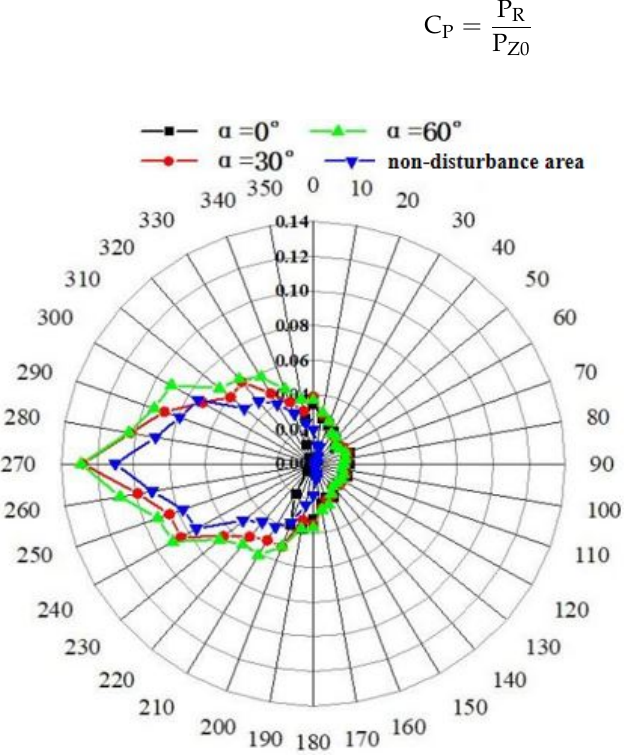
Figure 14. Circumferential distribution of rain-pressure coefficient.